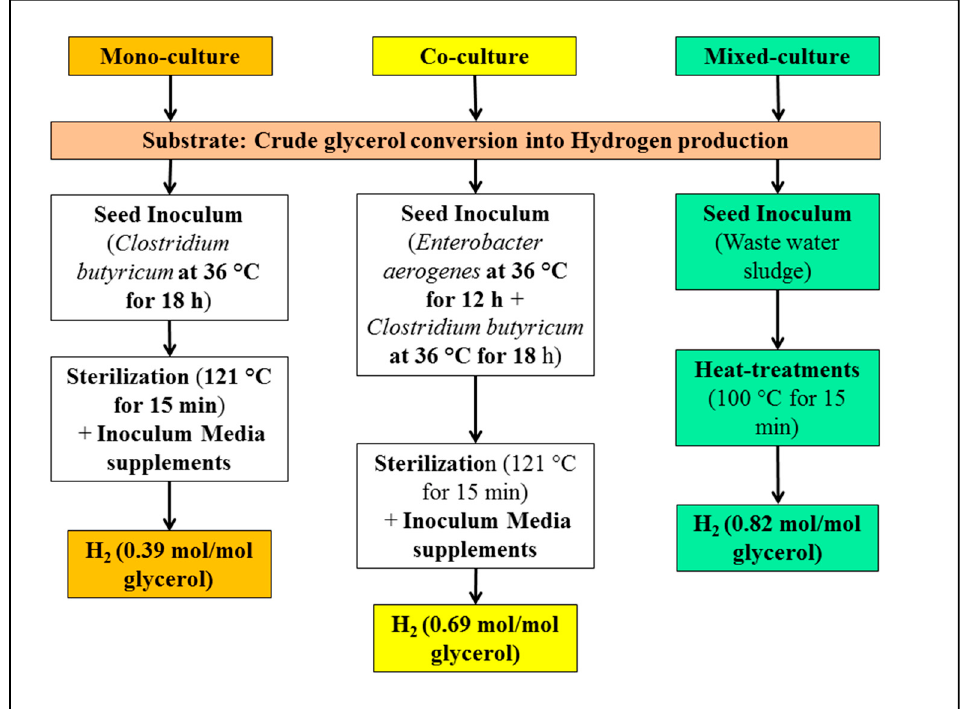
Figure 5. Comparison of the mixed-culture system across mono- and co-culture system using a common substrate crude glycerol for hydrogen production, in reference to seed inoculum, sterilization time and cost of inoculum media supplements.